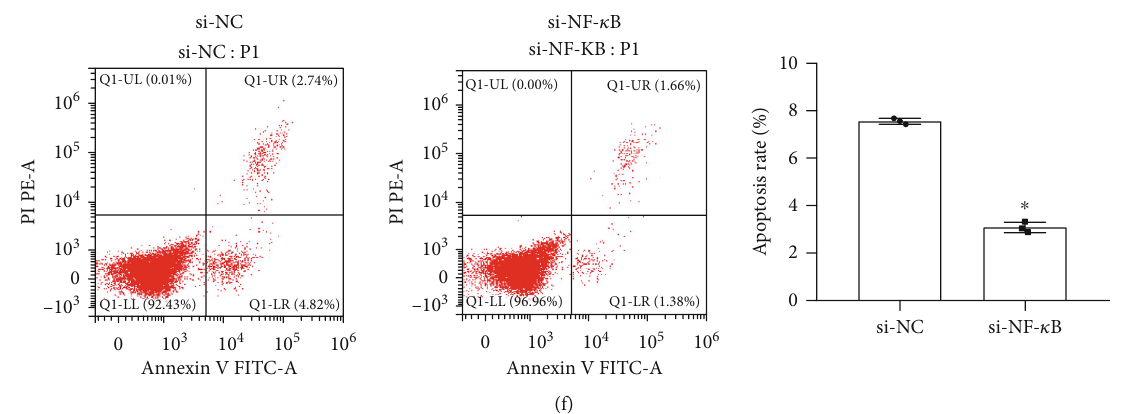
Figure 4: Astrocytes were protected by inhibition of NF- κ B. (a) qRT-PCR tested the expression of NF- κ B. (b) ELISA was used to measure the content of IFN- γ , IL-6, IL-1 β , and TGF- β 1 in astrocytes. (c) qRT-PCR detected the expression of iNOS. (d) Western blot measured the protein expression of iNOS. (e) Fluorescence intensity of claudin 3, occludin, and ZO-1 was detected by immuno fl uorescence (scale bar, 100 μ m). (f) Flow cytometry was used to measure the apoptosis rate of astrocytes. ∗ Compared with the si-NC group, P < 0 : 05 . The above experimental results were all measurement data. Data are expressed as the mean ± SD . The unpaired t -test was used between the two